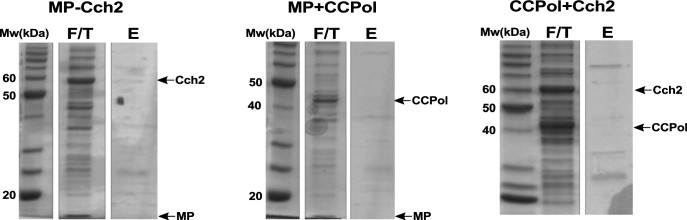
Pairwise pulldowns of Cch2 operon proteins: untagged controls.In each experiment (performed as those shown in Figure 2b), two proteins were co-expressed with each other. Cleared E. coli lysates were applied to Nickel-sepharose beads and flow-through (F/T) fractions were collected. Proteins were eluted with imidazole (E) and all samples were analyzed on SDS-PAGE.